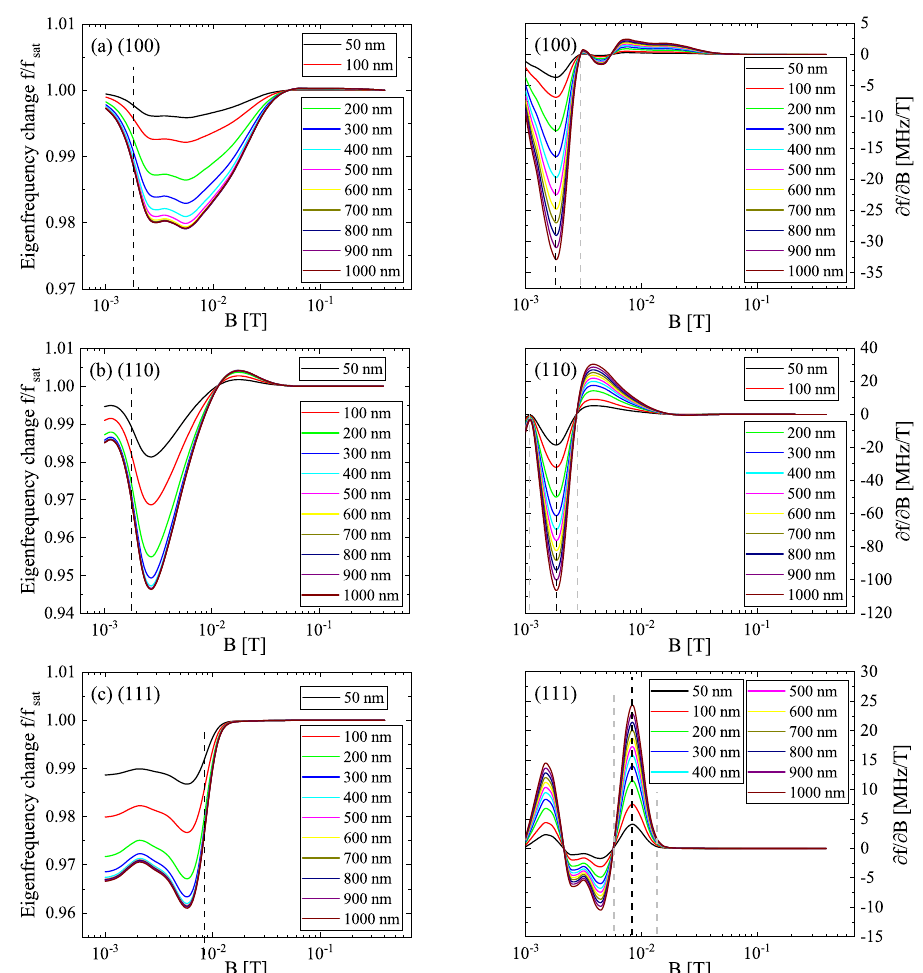
Figure 4. Relative eigenfrequency change f / f sat (left hand side) and the respective specific sensitivity ∂ f / ∂ B (right hand side) of the three principal axes ( a ) (100), ( b ) (110) and ( c ) (111) for Nickel layer thicknesses t Ni in the range of 50–1000nm. The point of highest absolute sensitivity as well as the dynamic range is marked by the lines,